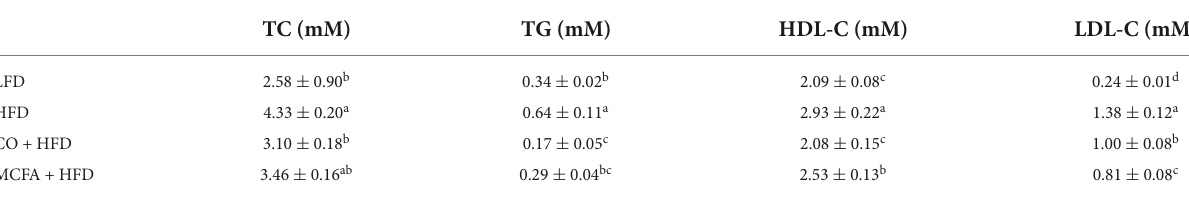
TABLE 3 Plasma lipid profile of